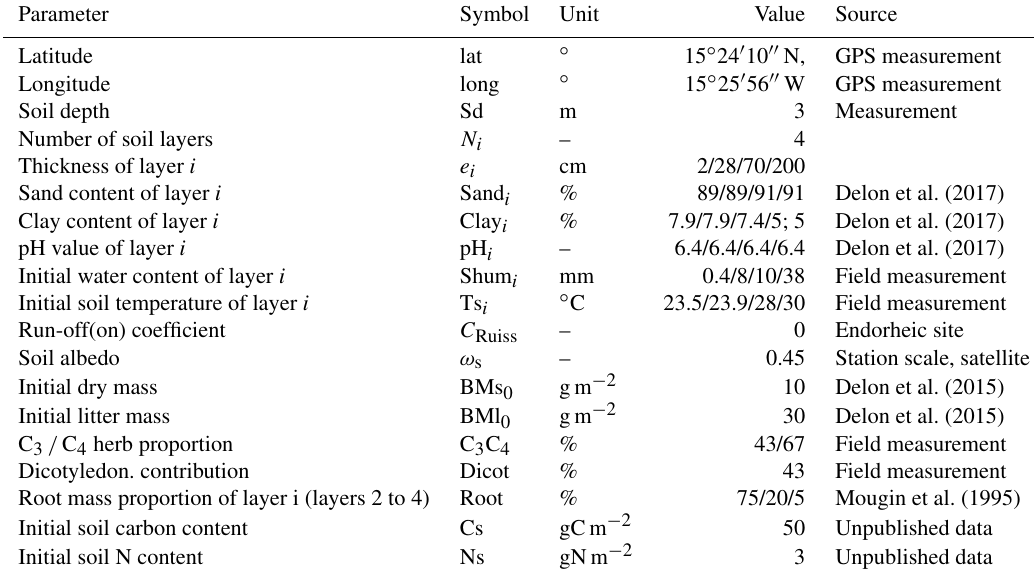
Table A2. Site parameters necessary for initialization of the STEP– GENDEC–NOFlux